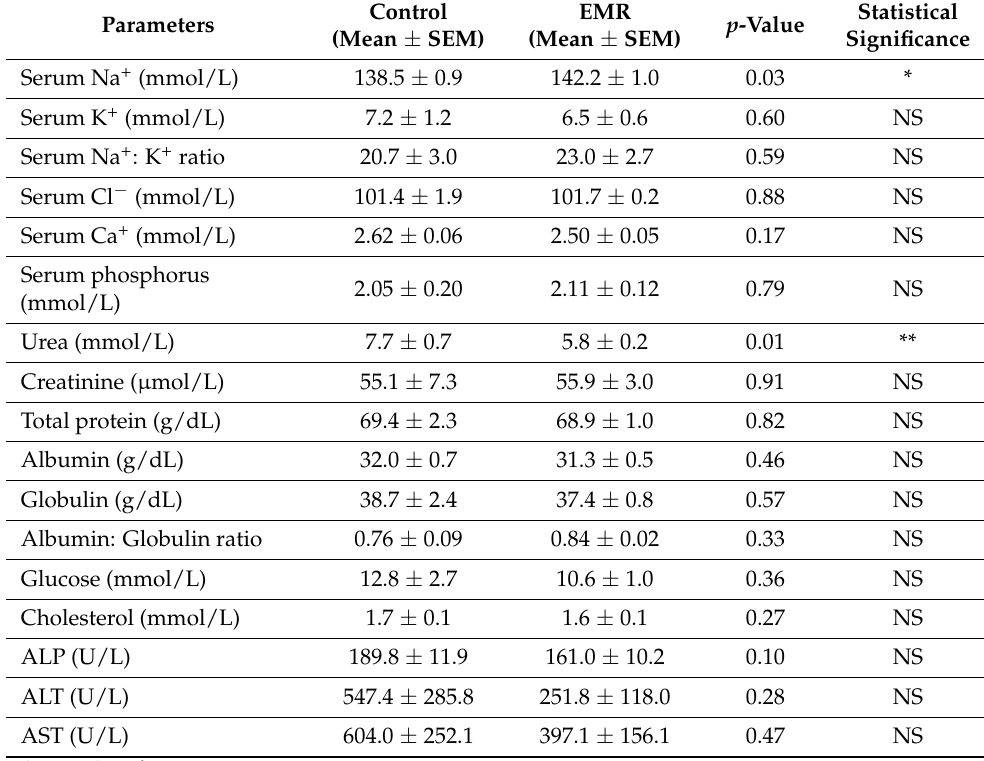
Table 2. Effect of 150 kHz IF EMR on biochemical parameters in SD rats after 2-month whole body